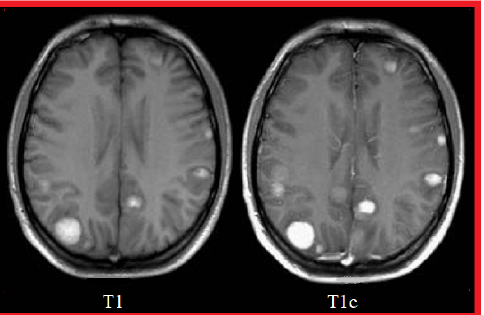
Figure 3. Comparison between a T1 ‐ Weighted MRI sequence without a contrast agent (T1) and the same sequence with a contrast agent (T1c).